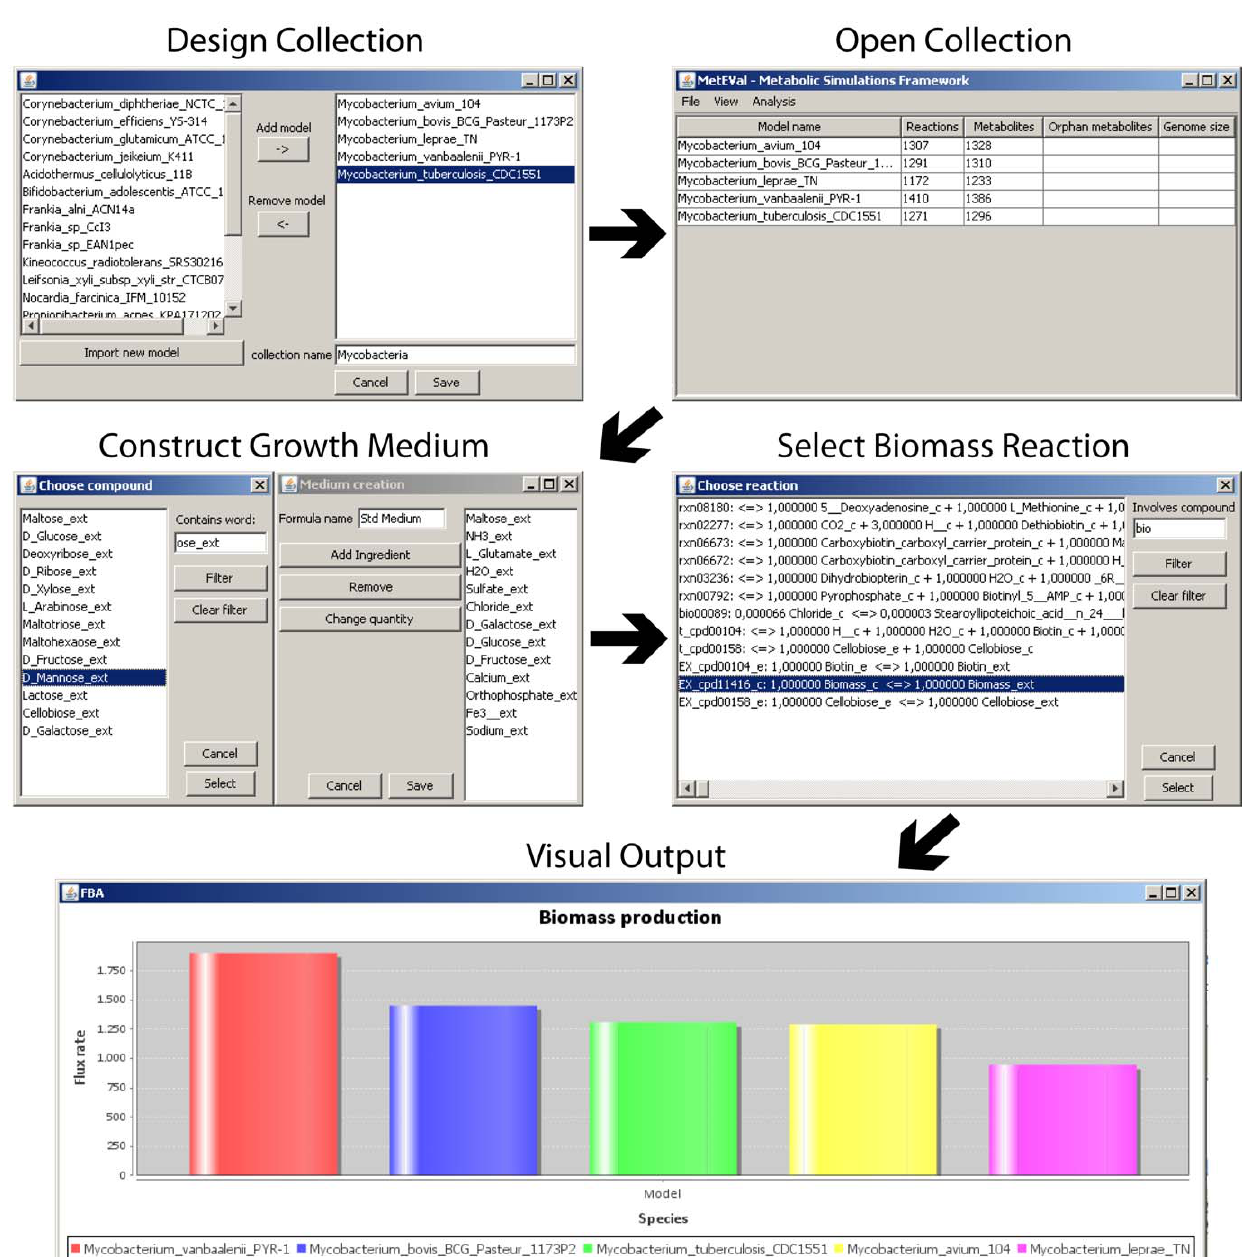
Figure 1. Workflow of comparative metabolic analysis in MultiMetEval.